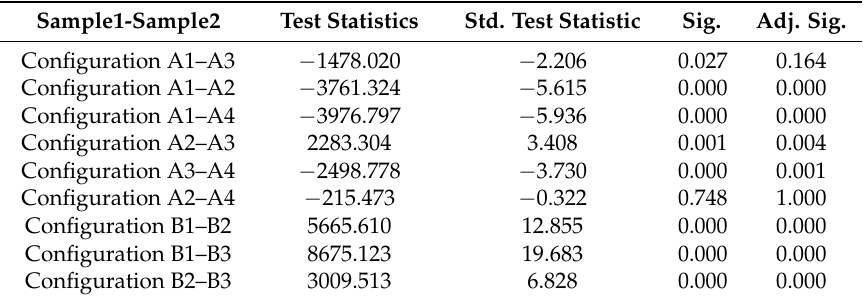
Table 19. Comparison of two parameters under different configurations.